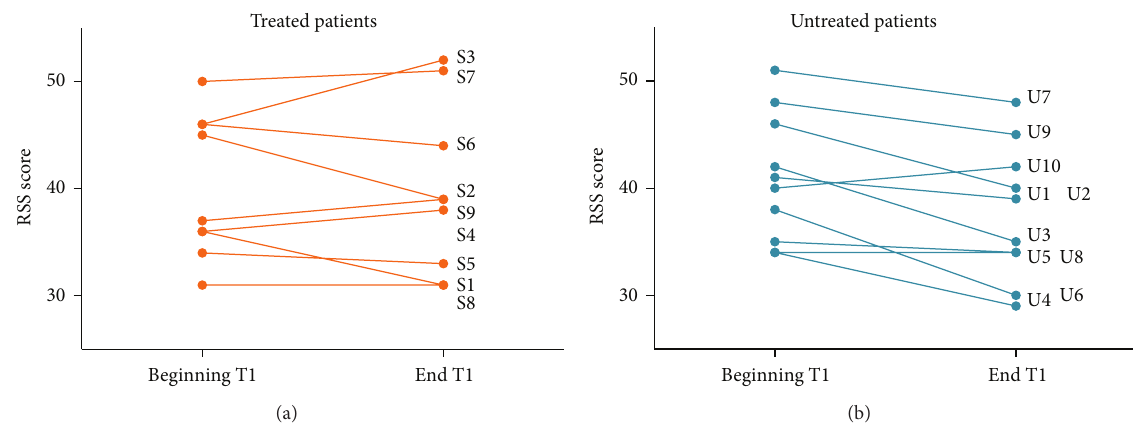
Figure 3: IGF1 treated patients do not show the same decrease in endurance to testing as untreated RTT patients. Endurance refers to the decrease in social/cognitive rating (RSS) from the beginning to the end of each visit (T0 and T1). In untreated patients, there is a significant decrease in scores from the start to the end of testing at T1. In treated patients, such a decrease was not seen following IGF-1 treatment. Recall that an increasing (positive on the graph above) score indicates improvement in social and cognitive